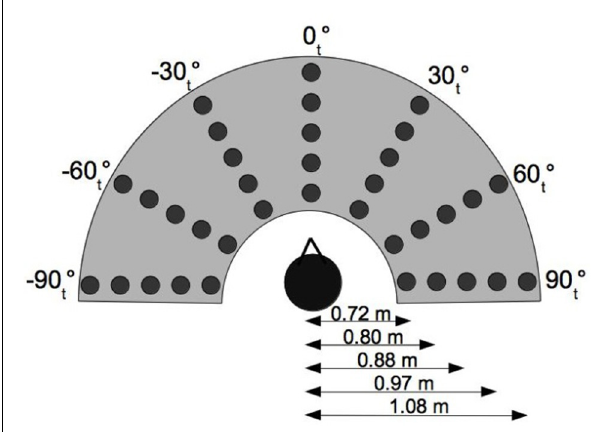
FIGURE 1 | Experimental setup. θ t indicates the source position in the subjects head coordinate